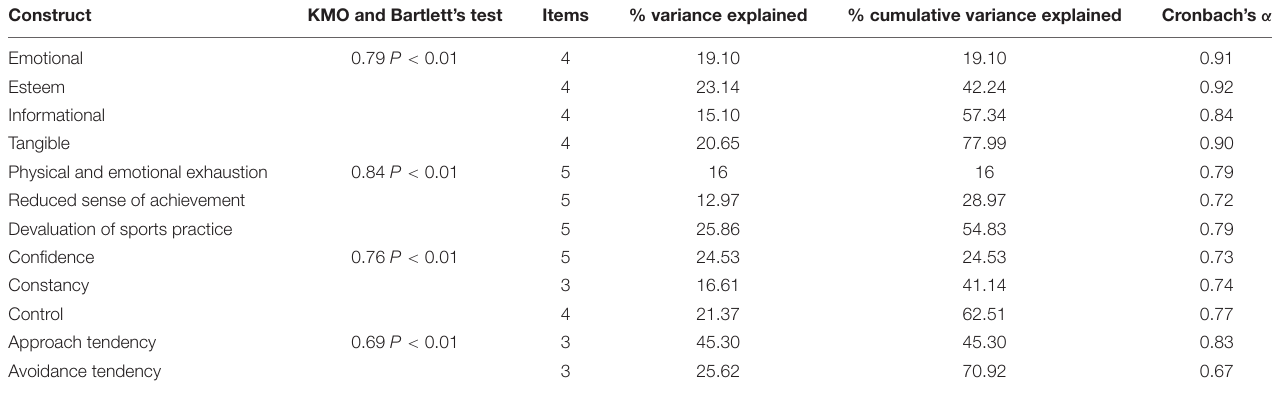
TABLE 2 | Reliability and validity test of the